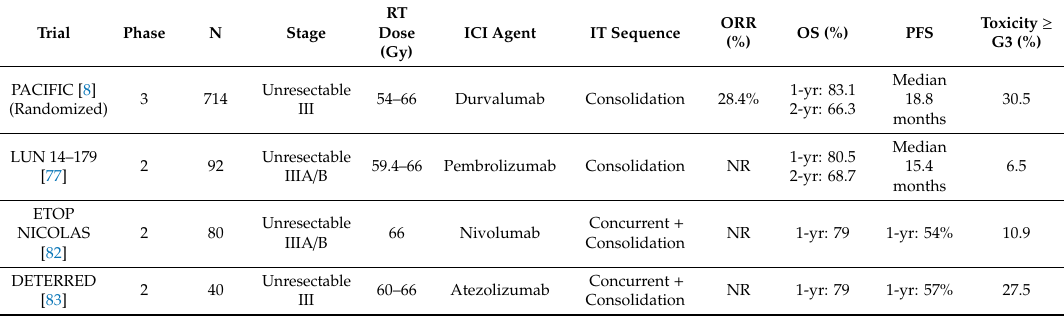
Table 4. Prospective studies that combine RT and ICI in stage III